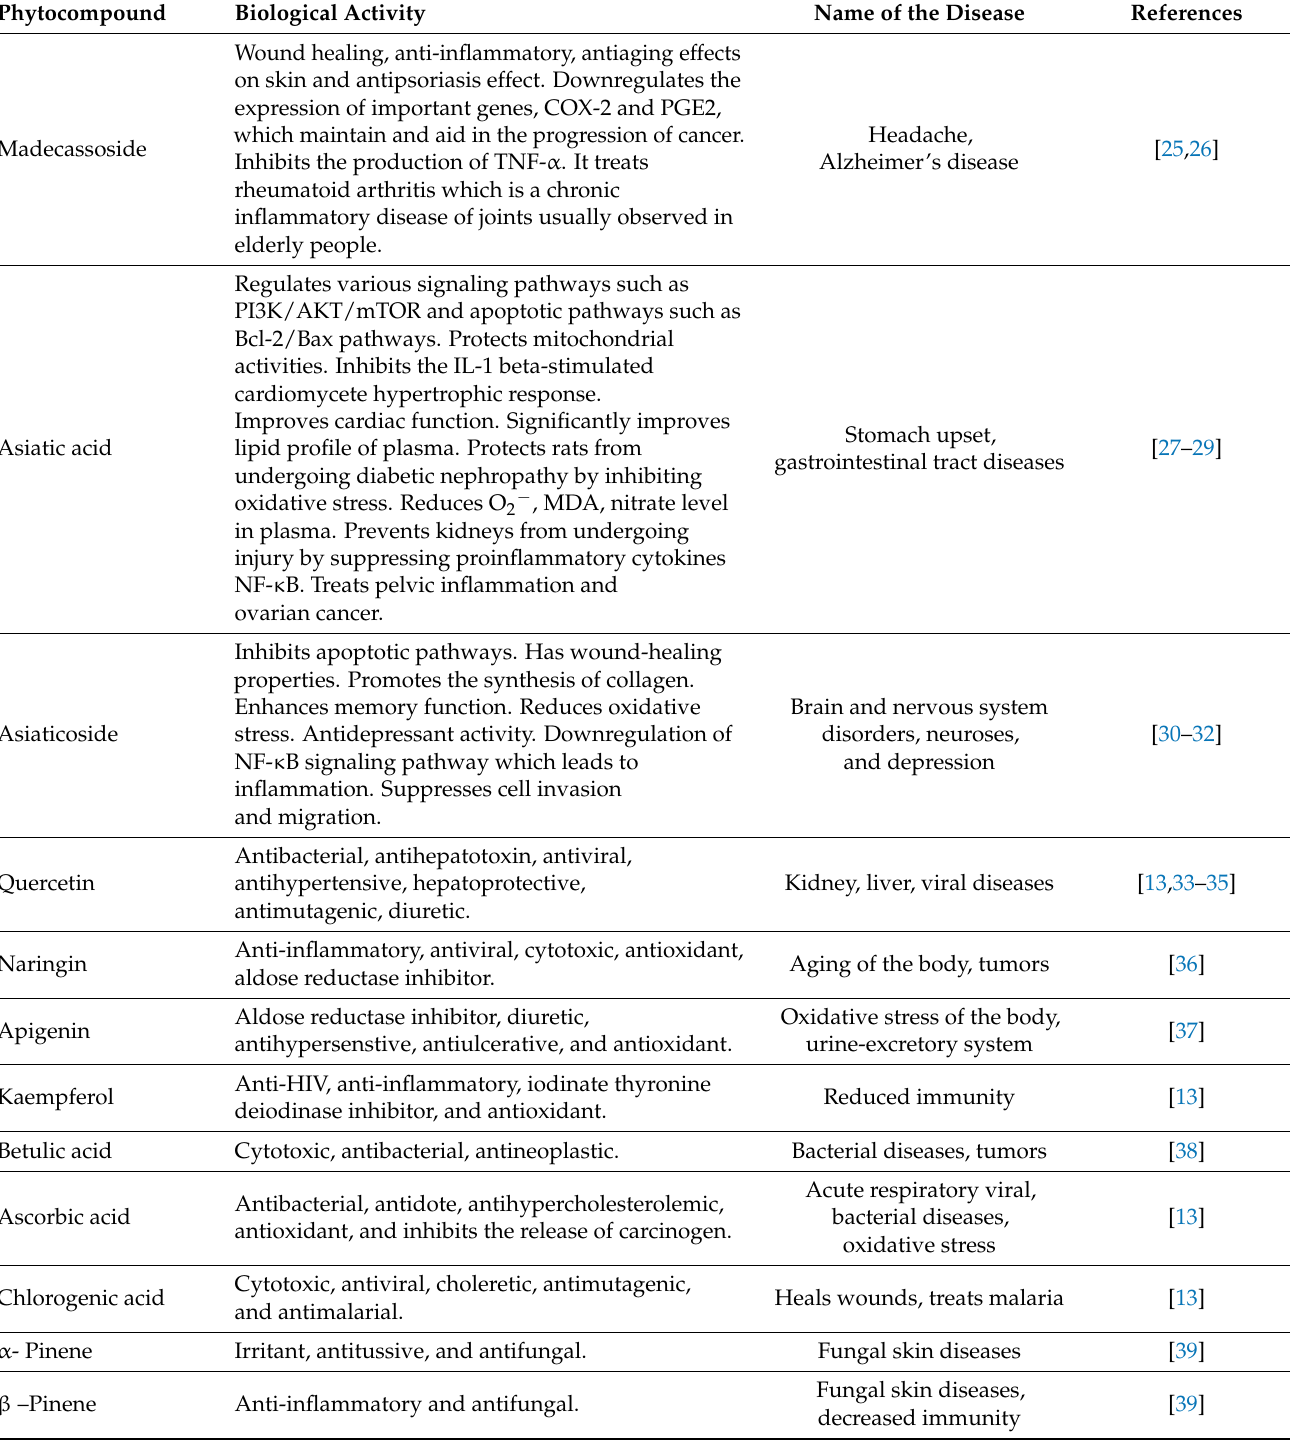
Table 2. Biological activities of various phytocompounds of Centella asiatica.